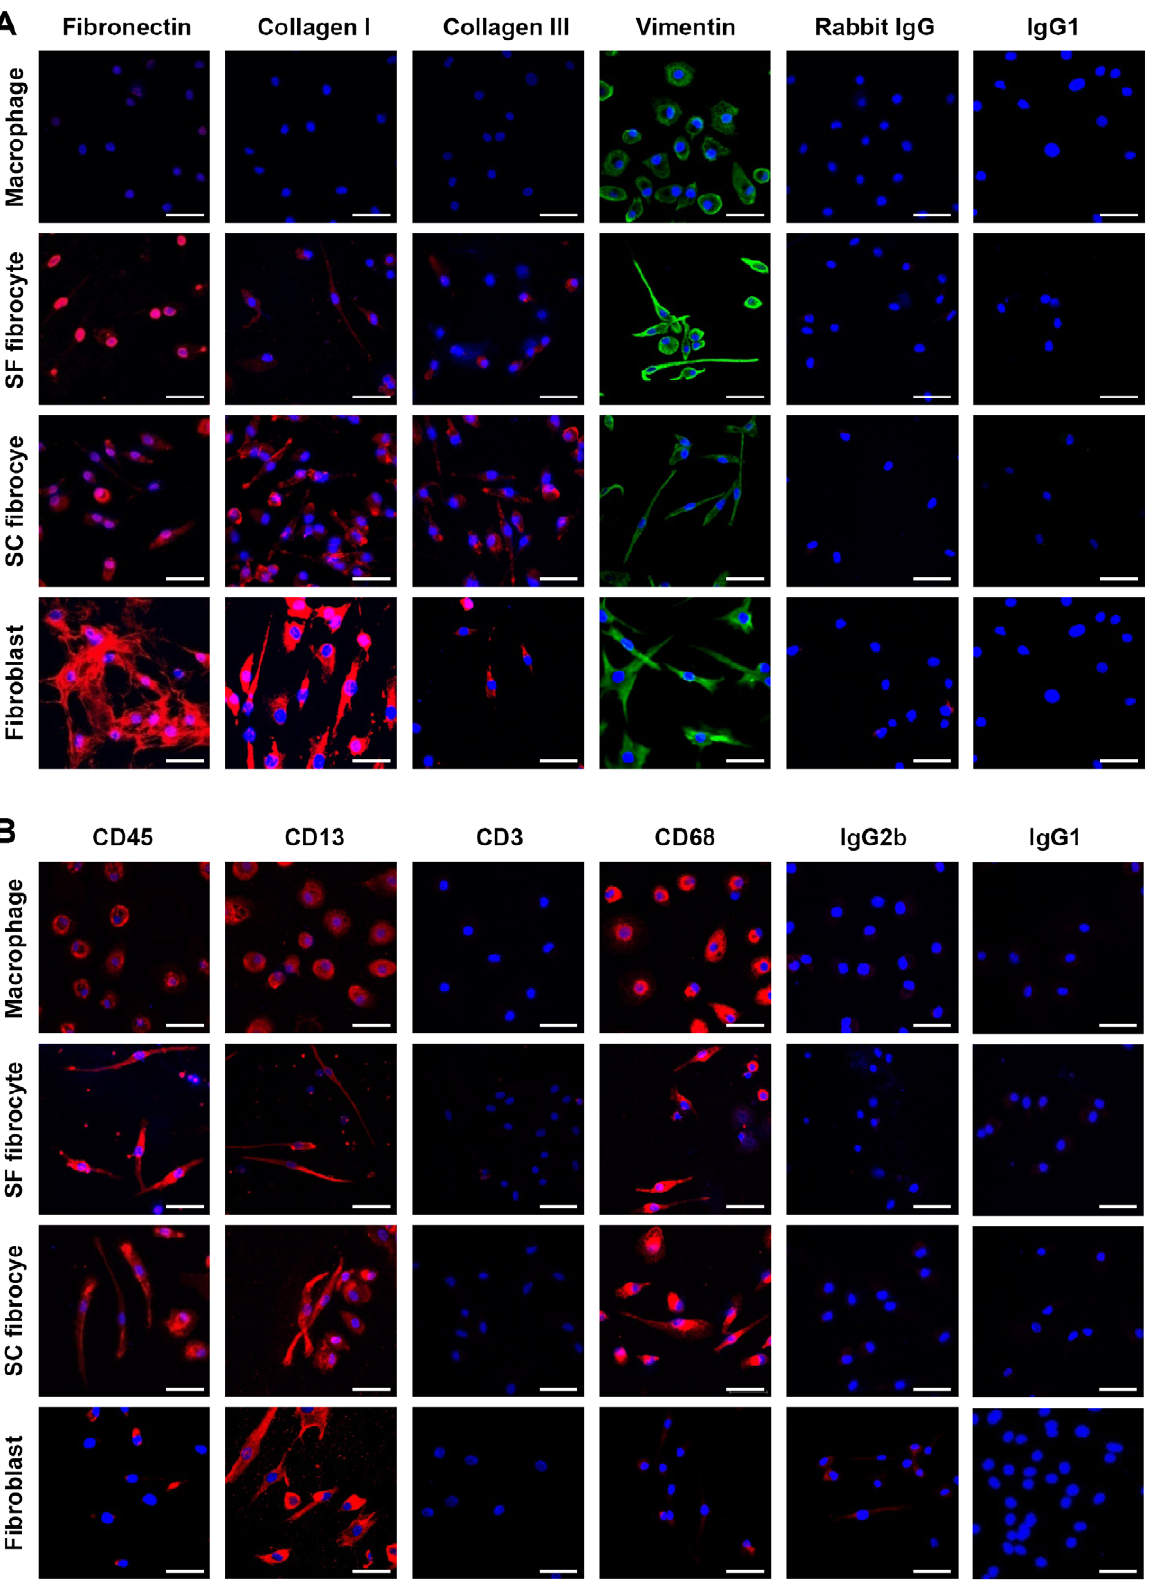
Figure 2. Both serum-free and serum-containing fibrocytes express both haematopoietic and stromal cell markers. Fibrocytes were generated from PBMC under serum-free (SF) and serum-containing (SC) culture conditions, as well as macrophages. Fibroblast cell lines were included as a positive control for stromal cell markers. Immunostaining is shown in red for the stromal markers fibronectin, collagens I and III and